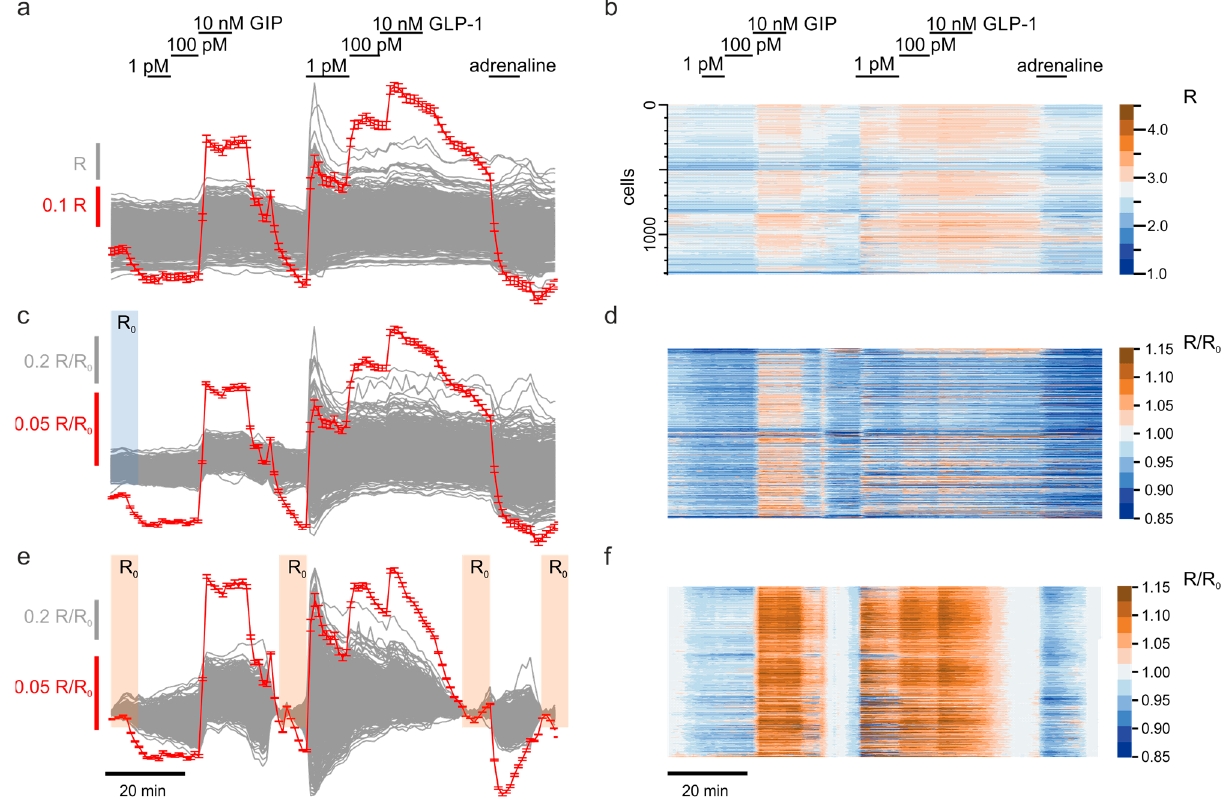
Figure 2. Baseline correction for populational time-lapse images. Changes in the cytosolic [cAMP] visualized via activity of PKA in response to various (ant)agonists, as indicated, recorded from a population of pancreatic islet cells. ( a ) raw data (grey traces, grey bar) and the average ± SEM trace (red). ( b ) As in ( a ) but color-coded according to the scale provided to show the response from each individual cell. ( c ) Raw data (grey) normalized to the initial fluorescence ( R/R 0 ), as indicated, average ± SEM (red). ( d ) Color-coded heat map of the data in ( c ). ( e ) Baseline-corrected data, using the baseline reference areas indicated. ( f ) Color-coded data from ( e ).